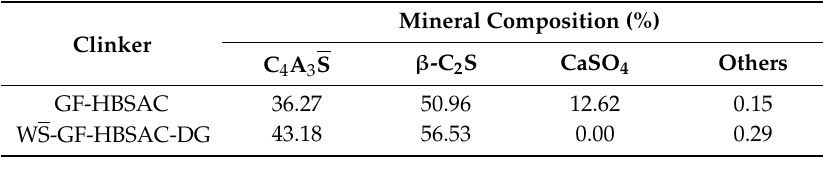
Table 4. Mineral composition of the Series GF-HBSAC-X cement clinkers.